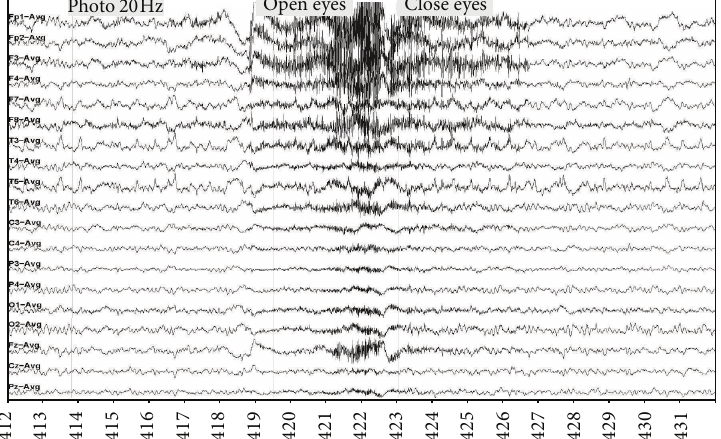
Figure 8: Example of Raw EEG signal with important muscle artifact (level 3/4), including 𝛼 rhythm and spikes (F7, T3,